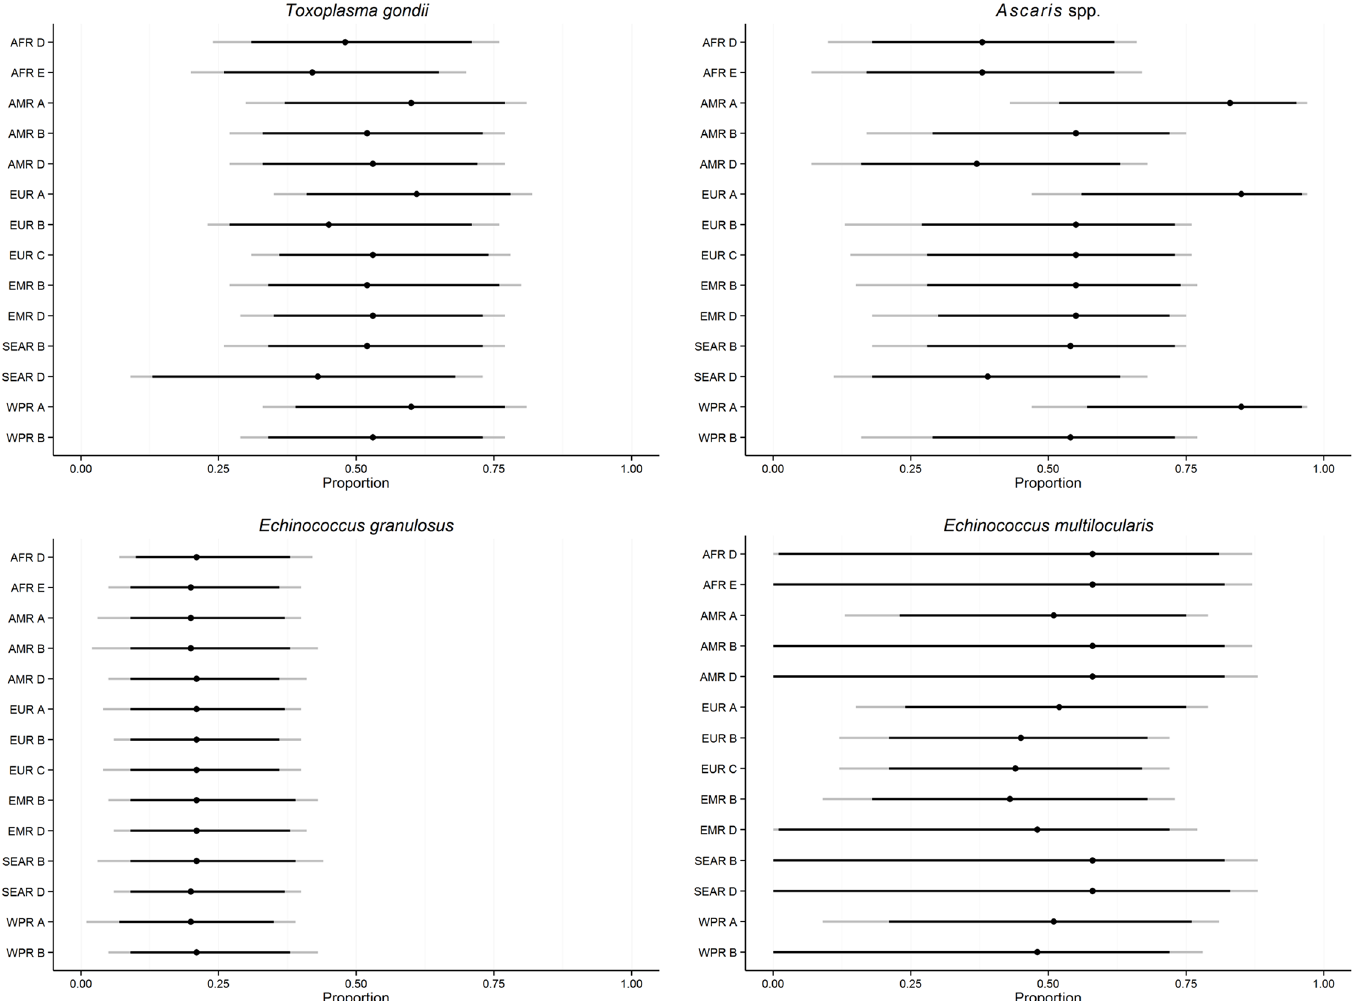
Fig 6. Subregional estimates of the proportion of foodborne illnesses caused by Toxoplasma gondii , Ascaris spp., Echinococcus granulosus , and Echinococcus multilocularis . Indicated on the line plot are the 2.5 th , 5 th , 50 th , 95 th and 97,5 th